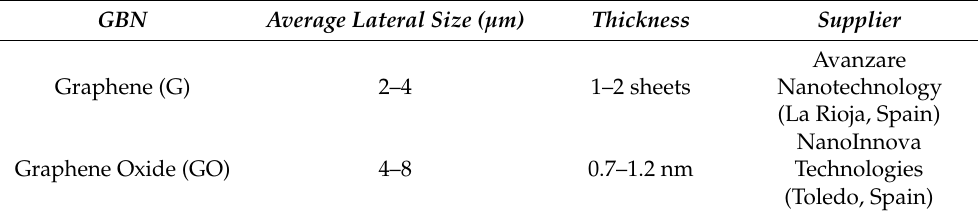
Table 2. GBN characteristics according to supplier data sheet.